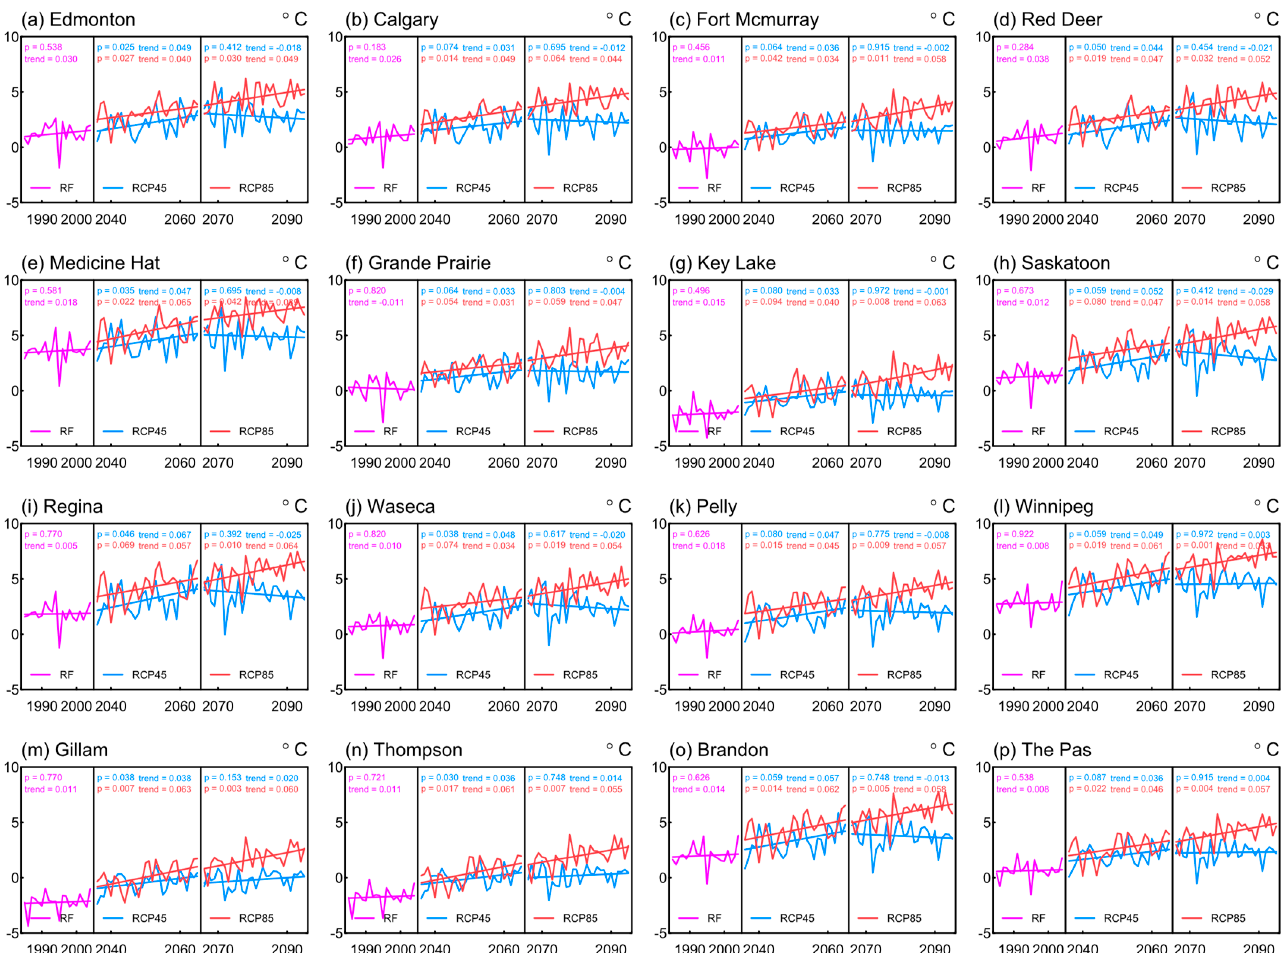
Figure 9. Temporal trends in annual averages of T mean at the 16 stations. The value of p and trend is derived from the MK test and the Theil–Sen estimator, respectively. The straight line represents the linear trend derived from the Theil–Sen estimator. ( a ) Edmonton, ( b ) Calgary, ( c ) Fort Mcmurray, ( d ) Red Deer, ( e ) Medicine Hat, ( f ) Grande Prairie, ( g ) Key Lake, ( h ) Saskatoon, ( i ) Regina, ( j ) Waseca, ( k ) Pelly, ( l ) Winnipeg, ( m ) Gillam, ( n ) Thompson, ( o ) Brandon, and ( p ) The Pas.